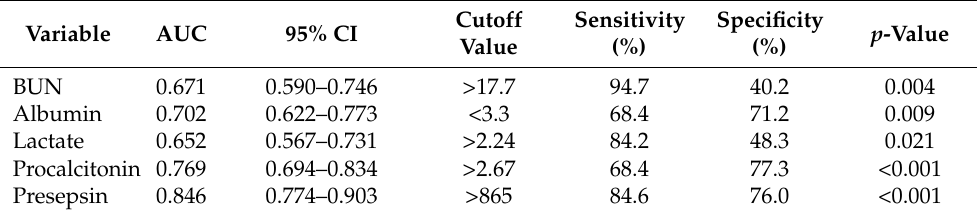
Table 7. The value of laboratory biomarkers for predicting 30-day hospital mortality in patients with COVID-19.